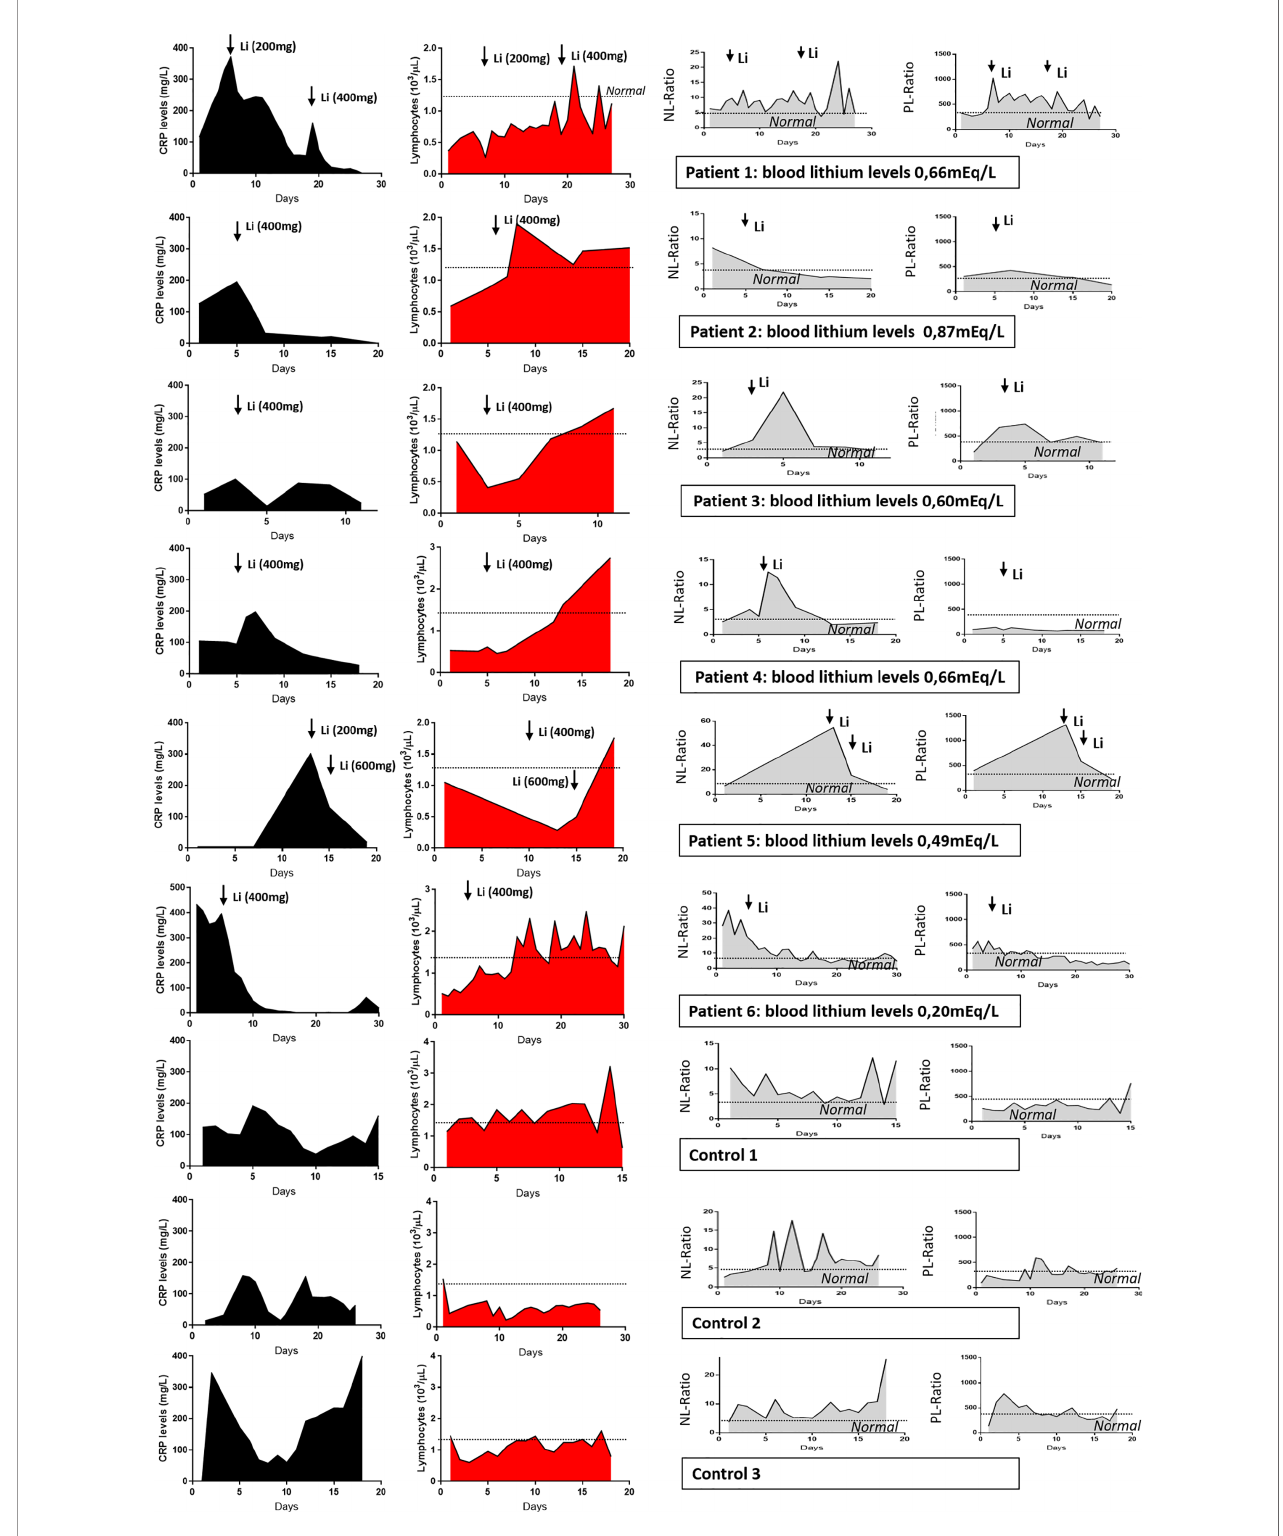
FIGURE 2 | Effect of lithium therapy on individual COVID-19 patients. C-reactive protein blood levels, number of lymphocytes and neutrophil-lymphocyte ratio and Platelet-lymphocyte ratio in six COVID-19 patients treated with lithium carbonate (plus regular therapy) and three control patients with regular therapy